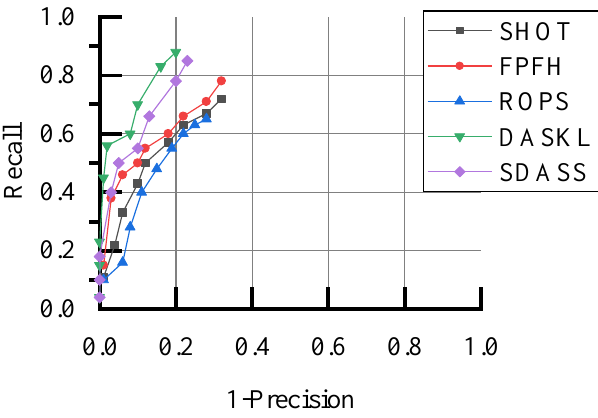
Figure 10. Performance comparison in real scene data.